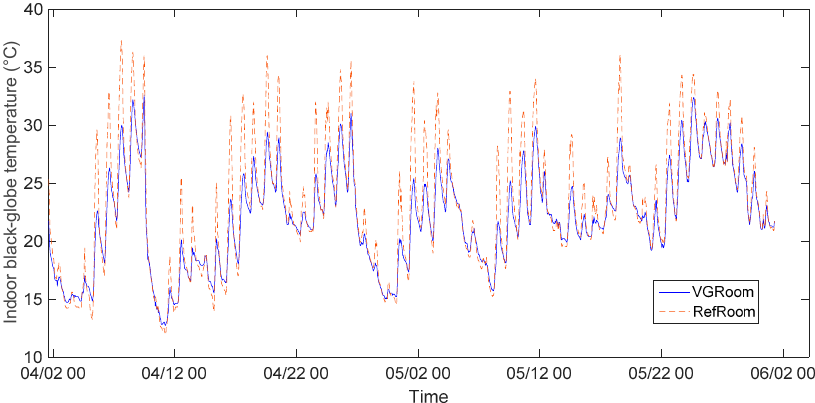
Figure 8. Indoor BGT values in the experimental rooms.